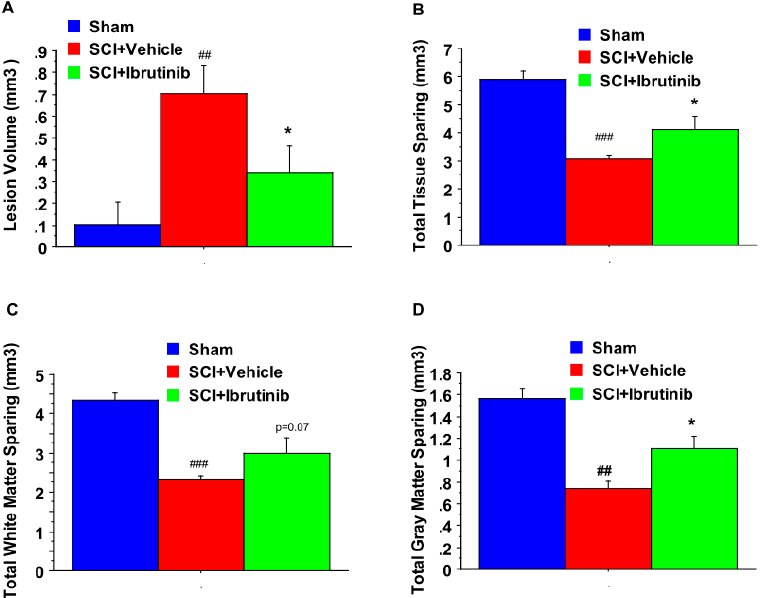
Figure 7. Effects of the 2 ‒ week treatment with Ibrutinib on lesion volume and total tissue sparing after SCI. Ibrutinib post-treatment (6 mg/kg/day, IP, starting at 3 h post-injury, daily for two weeks) resulted in a significant decrease in lesion volume ( A ), and a significant improvement in total tissue sparing ( B ). The increase in total white matter sparing following Ibrutinib treatment did not reach statistical significance ( C ). Ibrutinib increased total gray matter sparing ( D ) after contusion injury to the spinal cord (T10, 180 kdyn) compared to vehicle controls. Data were presented as mean ± SEM and analyzed with repeated measures ANOVA followed by Bonferroni post-hoc analysis, * p < 0.05 (Ibrutinib treatment at 6 mg/kg/day vs. vehicle treatment), ## p < 0.01 & ### p < 0.001 (compared with Sham), n = 5/group.